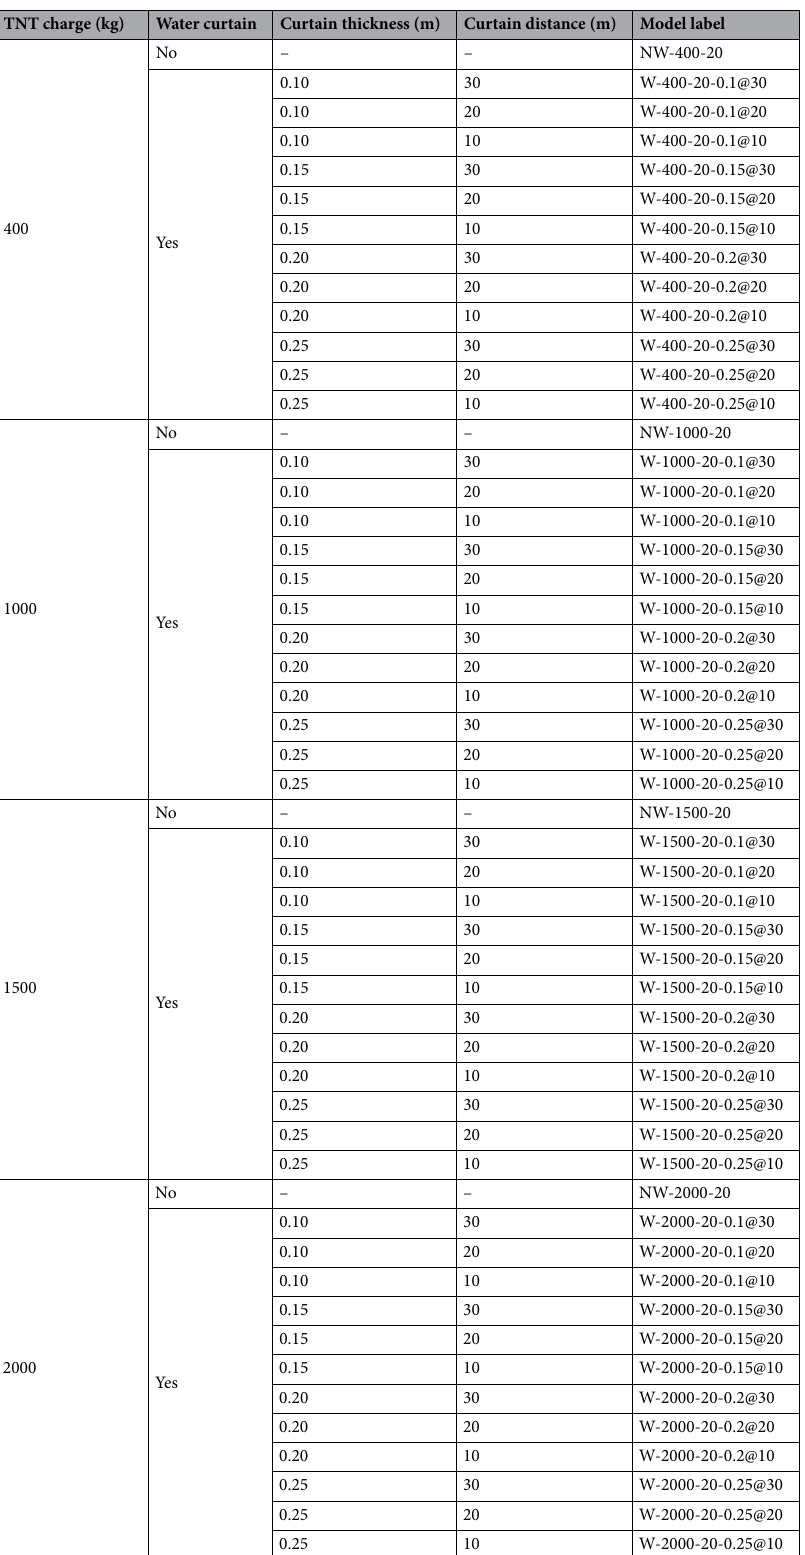
Table 7. Labels of the FEA models and their corresponding